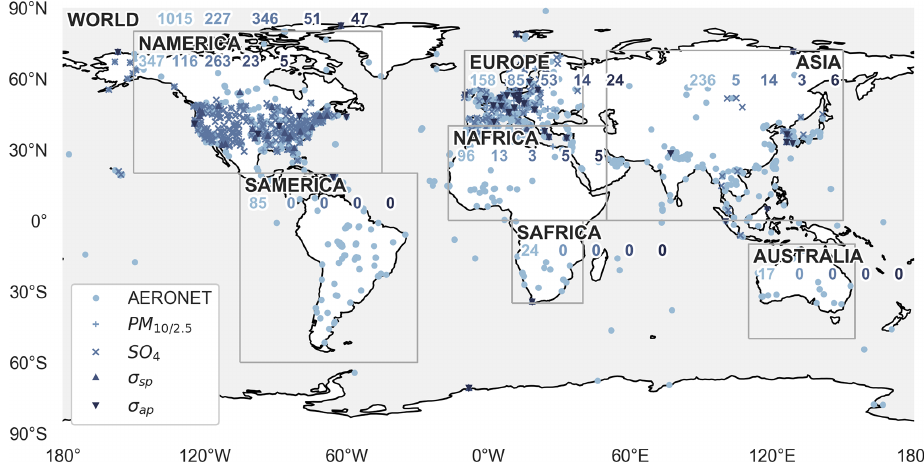
Figure 2. Distribution of the observations within the different regions considered in this study. The numbers reported within each region correspond to the maximum number of stations given for the observation networks, corresponding to the five observation types found in the legend.